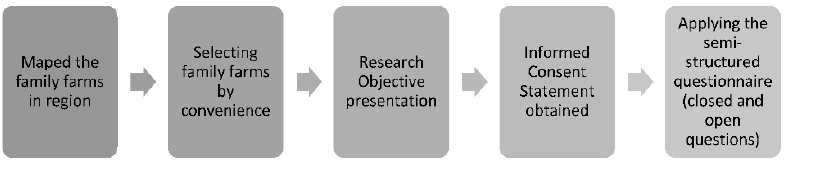
Figure 1. Steps of data collection